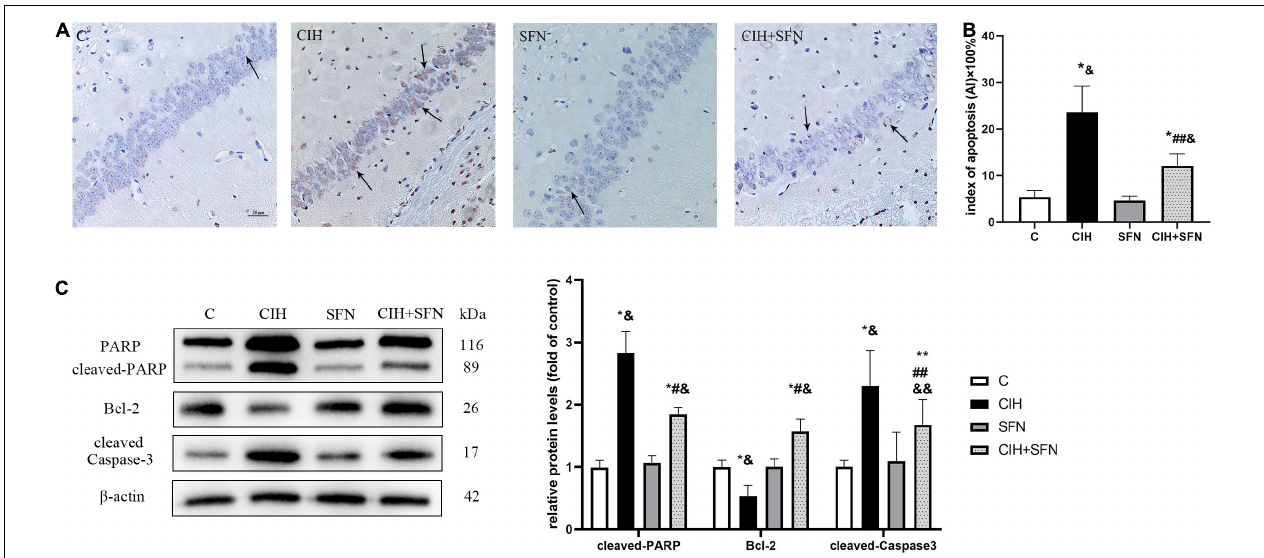
FIGURE 2 | SFN reduces caspase 3-dependent neuronal apoptosis in hippocampal CA1 region. (A,B) Neuronal apoptosis in hippocampal CA1 region. Apoptotic neurons were detected using TUNEL staining. Arrows indicate apoptotic neurons. Magnification × 400. Bar: 20 µ m. AI: apoptotic index. (C) Representative immunoblots and analysis of cleaved PARP, cleaved caspase 3 and Bcl-2 in each group from the hippocampus. n = 5, * p ≤ 0.01 vs. C; ** p ≤ 0.05 vs. C; # p ≤ 0.01 vs. CIH; ## p ≤ 0.05 vs. CIH; & p ≤ 0.01 vs. SFN; && p ≤ 0.05 vs. SFN.